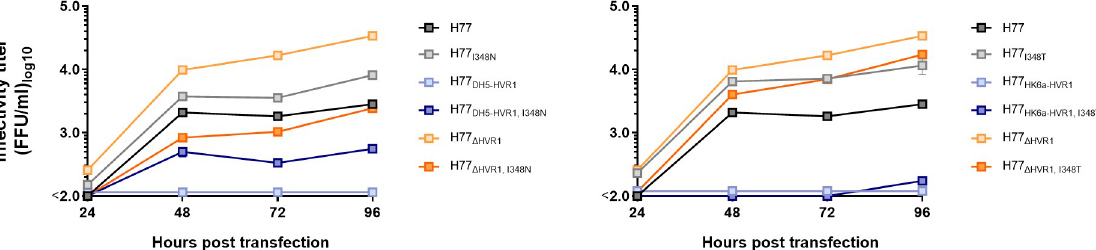
Fig 3. The substitutions I348N and I348T specifically compensate attenuated H77 HVR1-swapped recombinants. Huh7.5 cells were transfected with in vitro transcribed HCV RNA of the indicated recombinants. Supernatants were collected 24, 48, 72 and 96 hours post transfection, and HCV infectivity titers were determined. At each timepoint, infectivity titers are represented as a mean of three technical replicates. Error bars represent standard deviation. Lower level of quantification was 100 FFU/ml. The substitutions are numbered according to H77 abs. ref. (GenBank #AF009606).